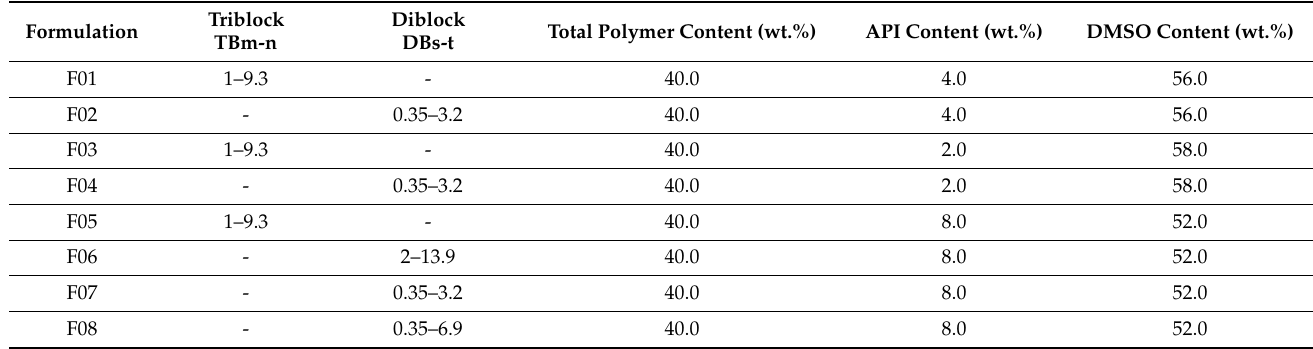
Table 1. Compositions of formulations delivering meloxicam.